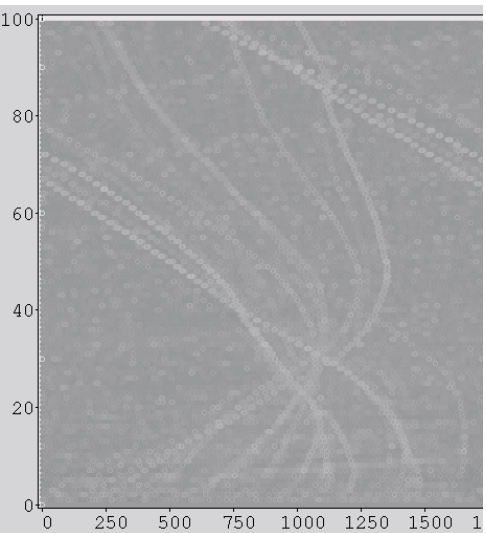
FIG. 1. 2.4 3 10 12 protons, one trace each 300 turns, vertical span 50 ms; abscissa in nanoseconds (ns).